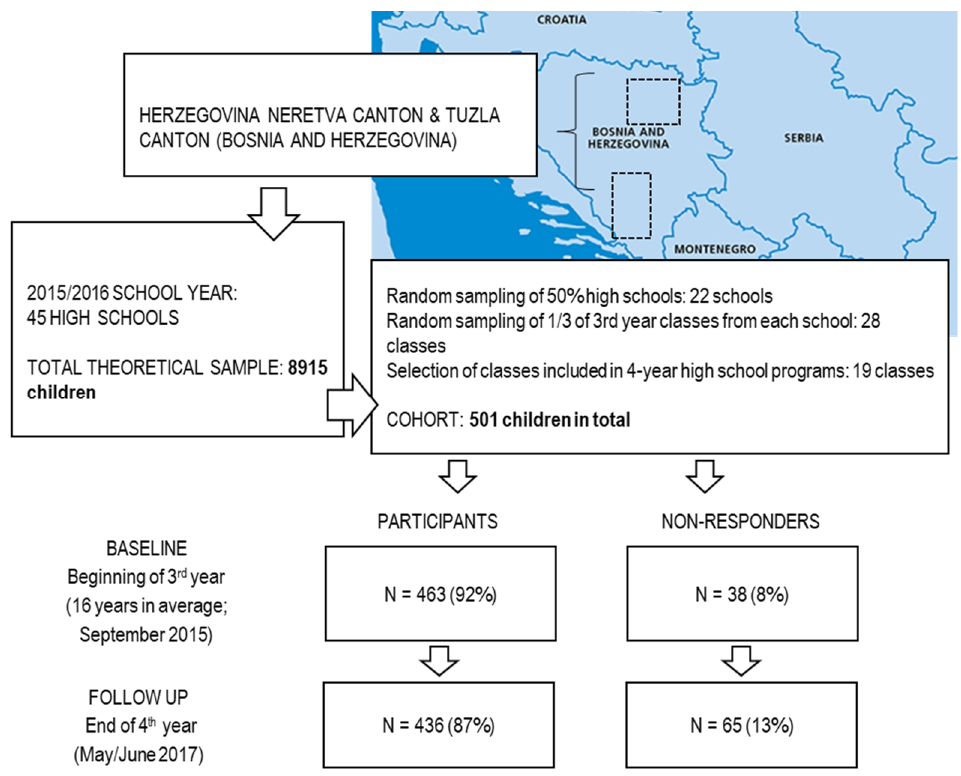
Figure 1. Location of the study, testing sequences, participant- and drop-out-rates.